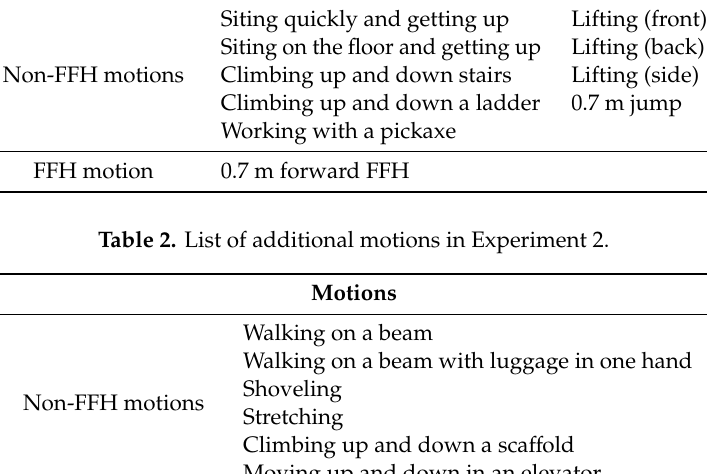
Table 1. List of motions in Experiment 1.